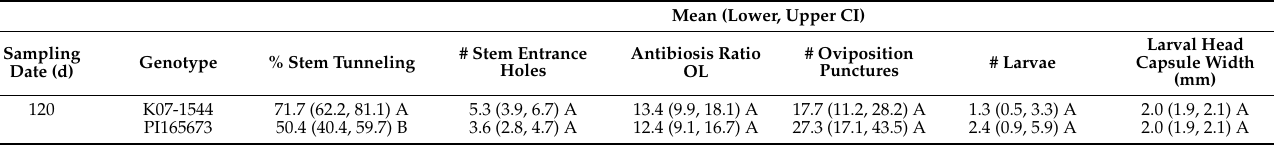
Table 7. Mean (lower, upper CI) OL antibiosis ratios; numbers of oviposition punctures, larvae and stem entrance holes; larval head capsule widths, and percent stem tunneling per plant in soybean genotypes K07-1544 and PI165673 infested with Dectes texanus in